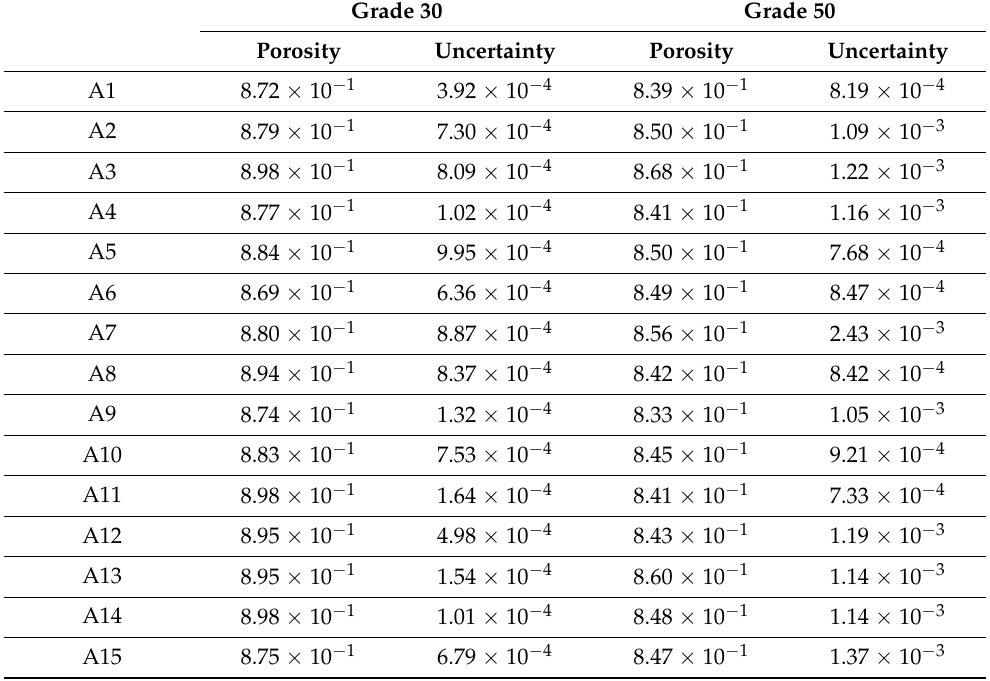
Table A1. The porosity of CFF samples of Grade 30 and 50 from supplier